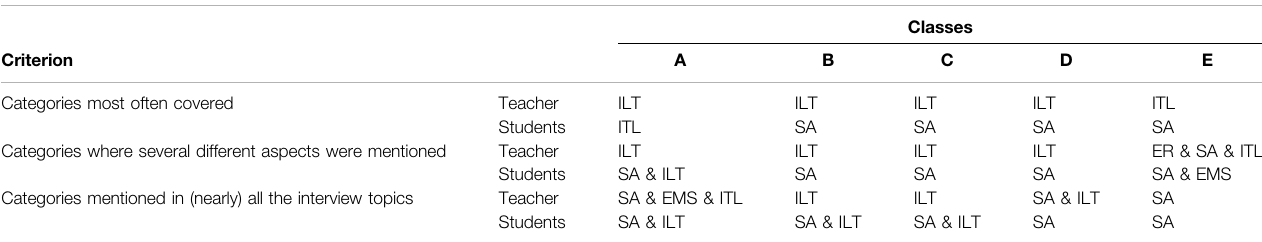
TABLE 4 | Overview of students and teachers ’ assessment